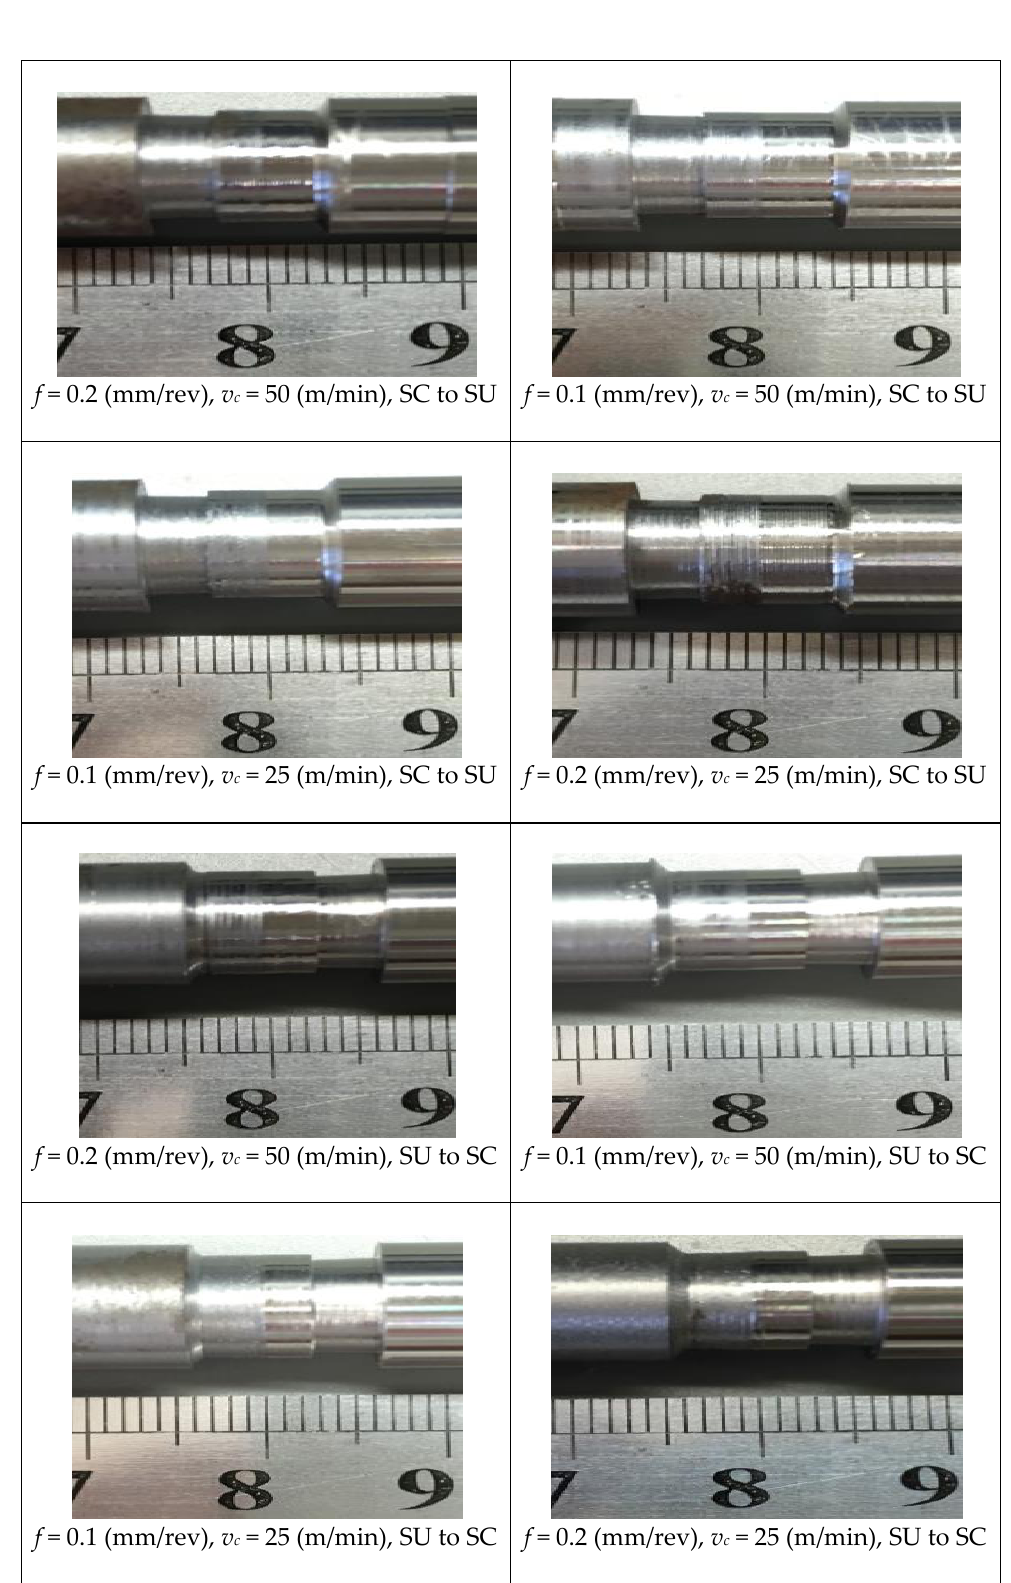
Figure A1. The SU–SC specimens.